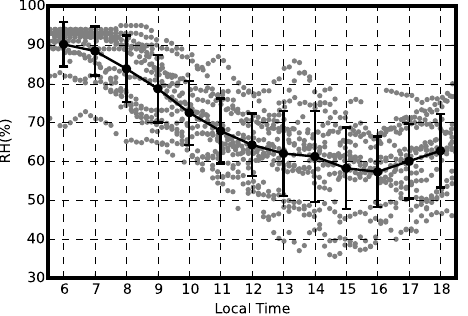
Figure 3. The scatter plots of RH for selected days, the black line is the average diurnal variation of RH.